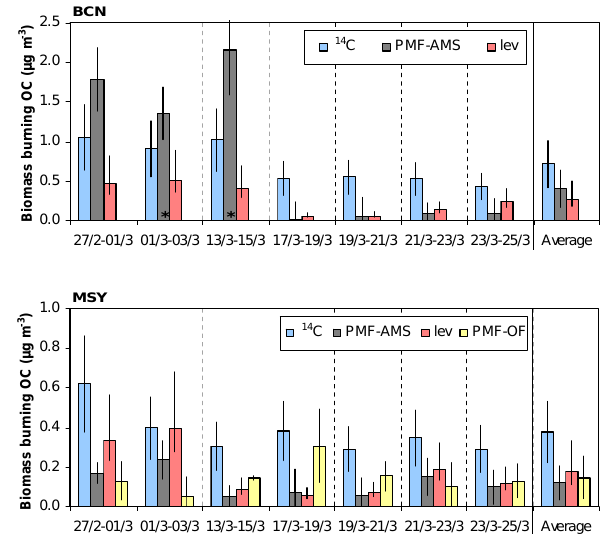
Fig. 6. Relative source apportionment to organic carbon during DAURE-W according to the 14 C technique and PMF results of AMS measurements. Numbers indicate the absolute concentra- tions in µgm − 3 . BCN averages exclude 01/03–03/03 and 13/03– 15/03 samples because of low availability of AMS data. HOC: hydrocarbon-like organic carbon; OOC: oxygenated organic car- bon (secondary); COC: cooking organic carbon; BBOC: primary biomass burning organic carbon; OC urb − nf : urban non-fossil or- ganic carbon.